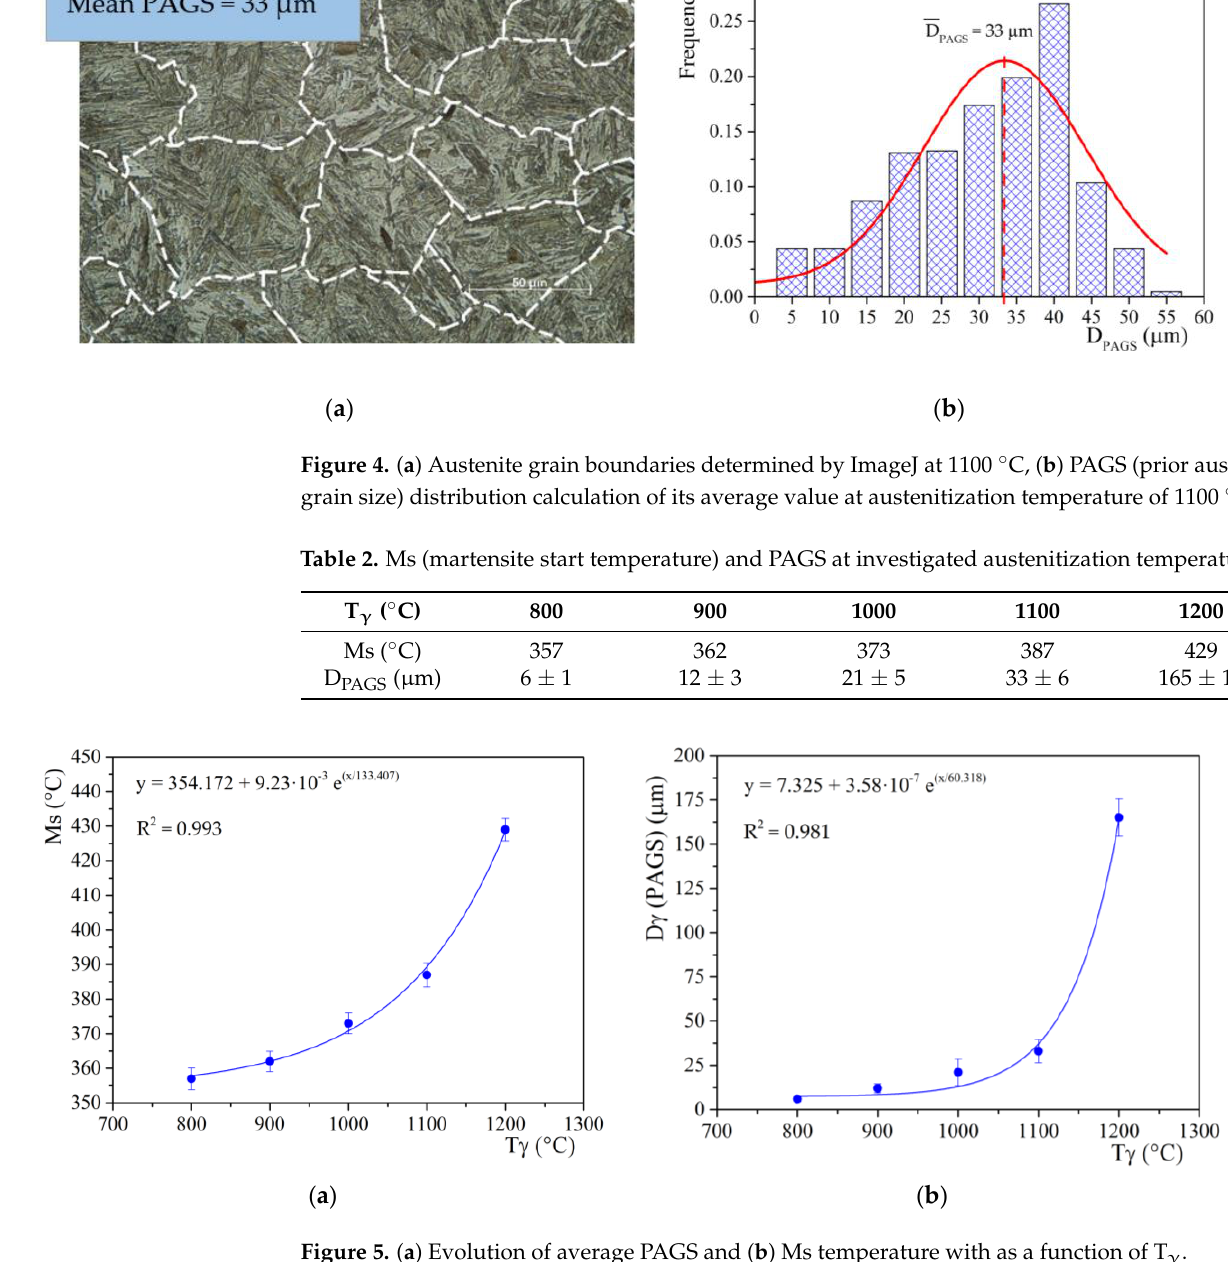
Figure 5. ( a ) Evolution of average PAGS and ( b ) Ms temperature with as a function of T γ.